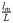
Correlation between the finger joint angle and the normalized moment arm, torque, or torque ratio calculated using MR images of digit III during a cylindrical grip and suspensory hand posture.The differences in lmL (A), τMCP and τPIP (B)τMCP#, and τPIP# (C), and τPIPτMCP (D), τMCP#τPIP# (E), were compared among Hylobates spp., Papio hamadryas, and Ateles sp. using generalized estimating equations (GEE). Circles, triangles, and squares show the data of Hylobates spp., Papio hamadryas, and Ateles sp., respectively. Symbols filled with black, R2 of the regression ≥0.7; symbol filled with gray, R2 of the regression ≥0.4; open symbol, R2 of the regression <0.4. Regression equations are shown in S4, S5 and S6 Tables.